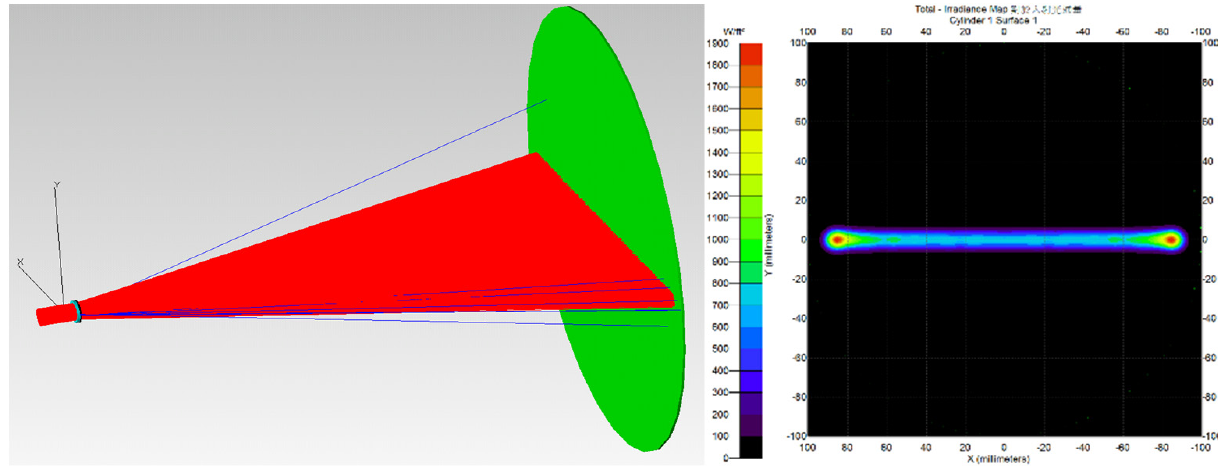
Figure 1. Optical design of lens for transforming Gauss-distributed spotlight into a uniform straight line.